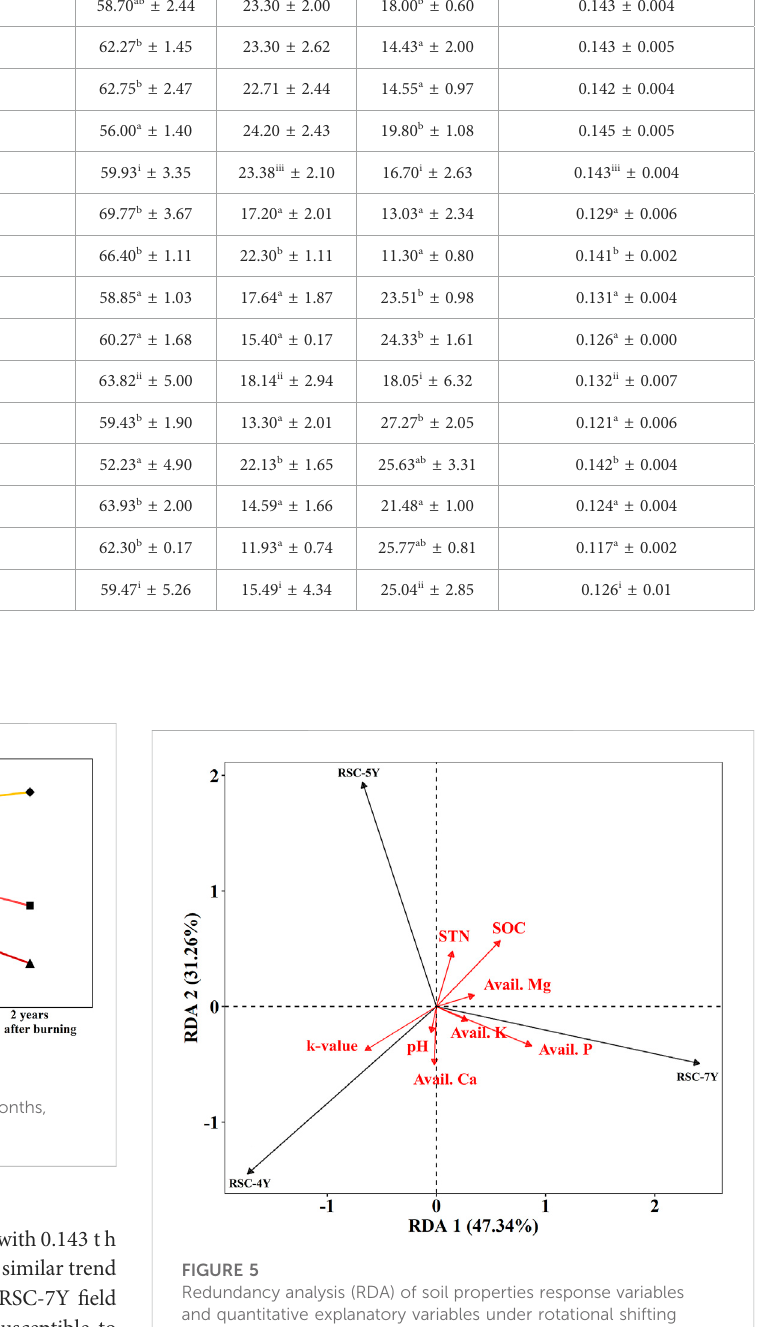
TABLE 4 Variations in soil physical properties: bulk density (Mg m − 3 ), proportions of sand, silt, and clay (%), and k -value (t h MJ − 1 mm − 1 ) along the fallow chronosequence. Field